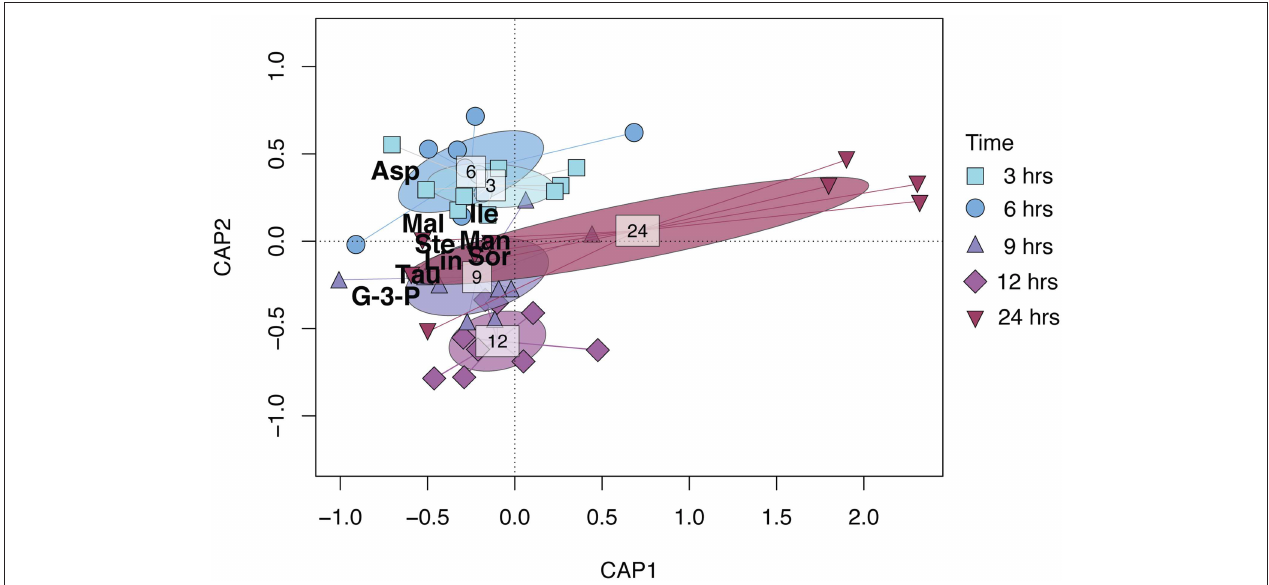
FIGURE 1 | CAP (Constrained Analysis of Principal coordinates) biplot based on the relative metabolite concentration matrix of R. subcapitata constrained by time after È -radiation exposure. Points represent individual samples and are shaped and colored by time after exposure (see figure legend). The ellipsoids represent the standard deviation for each time after exposure. The metabolites shown in the figure—Asp (aspartic acid), Tau (taurine), G-3-P (glycerol-3-phosphate), Mal (malic acid), Lin (linoleic acid), Ste (stearic acid), Man (mannitol), Sor (sorbitol), and Ile (isoleucine)—contributed 80% to the dissimilarity as identified in the SIMPER analysis ( Table S1 ).